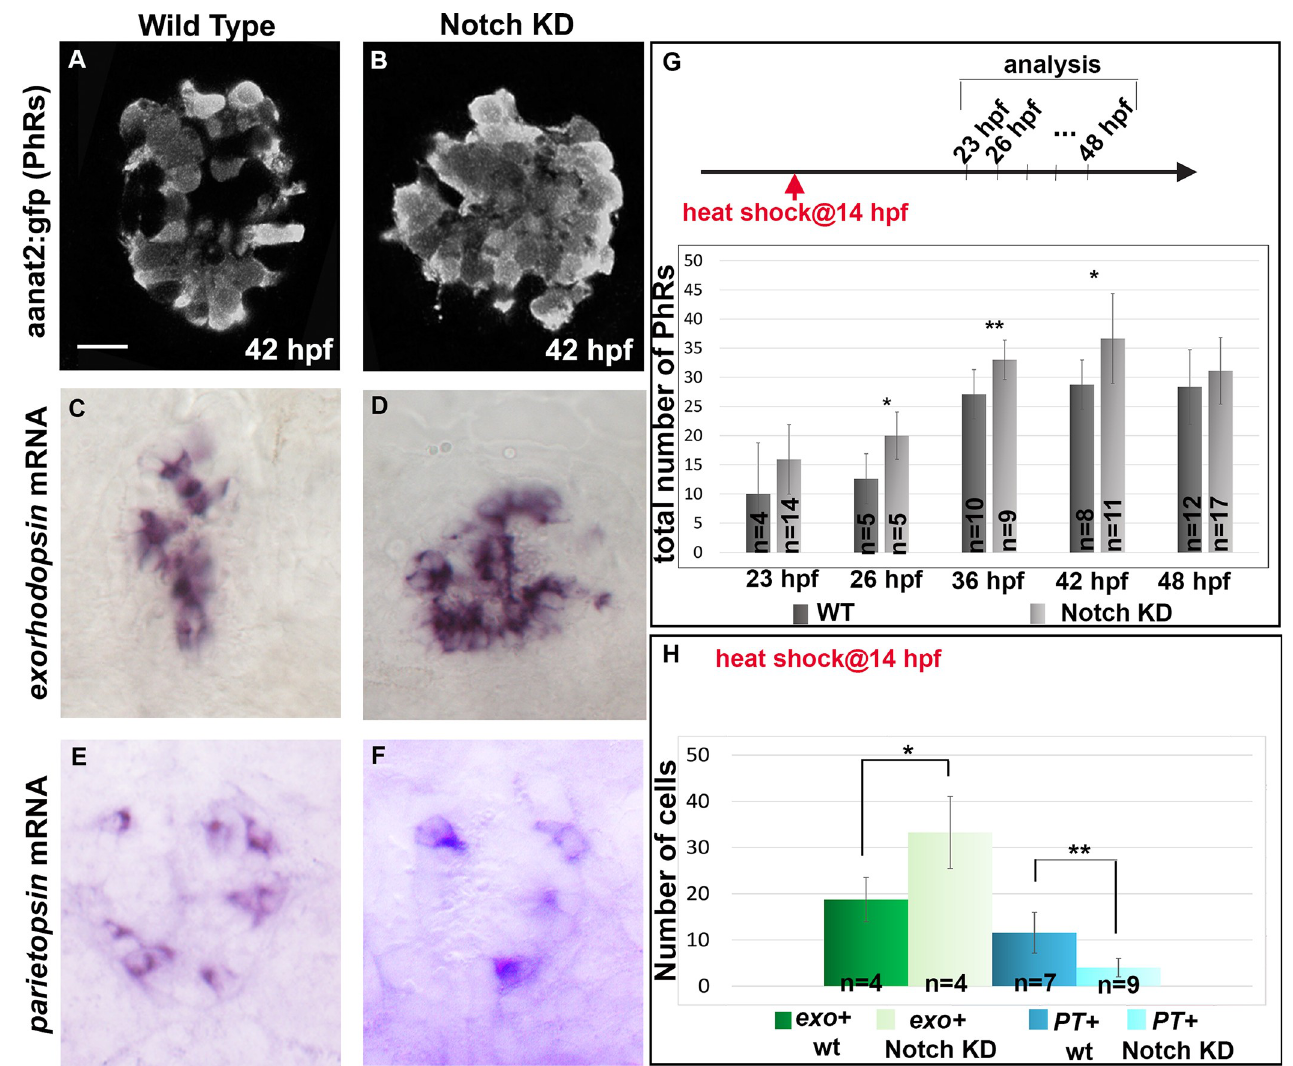
Fig 3. Impairing Notch activity modifies the timing of PhR differentiation and favors early PhR fate at the expense of late PhR fate. (A-B) Representative confocal sections showing the expression of the Tg(aanat2 : gfp) y8 (aanat2:gfp) transgene in Tg(hsp70l : dnXla . Rbpj-MYC) vu21 (referred to as Notch KD) and wt siblings at 42 hpf. (C-F) Expression of exorh and PT in Tg(hsp70l : dnXla . Rbpj-MYC) vu21 and siblings at 48 hpf (C-D) and 66 hpf (E-F). (G) Counts of Tg ( aanat2 : gfp ) y8 + cells at various stages in Tg(hsp70l : dnXla . Rbpj-MYC) vu21 and siblings. The stage is indicated on the x-axis. (H) Counts of exorh+ and PT + cells in Tg (hsp70l : dnXla . Rbpj-MYC) vu21 and sibling embryos after in situ hybridization. Stages are 48 hpf for exorh+ and 66 hpf for PT + cells. Scale bars represents 10 μ m. Heat shock was performed at 14 hpf. Error bars represent SD. � p < 0.05, �� p < 0.001 using a Mann Whitney test. Underlying data can be found in S1 Data. exorh , exorhodopsin ; hpf, hours post fertilization; KD, knock-down; PhR, photoreceptor; PT , parietopsin ; wt, wild type.